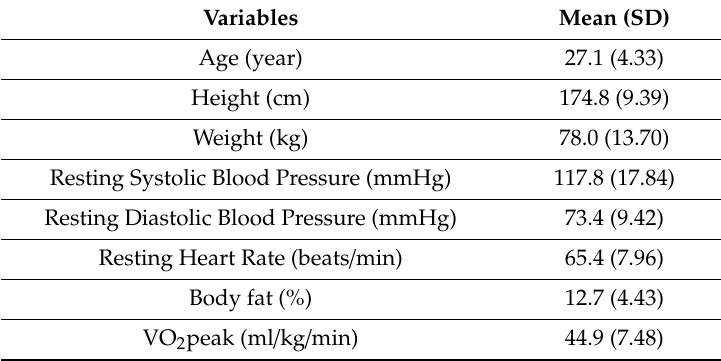
Table 2. Participants’ basic characteristics.